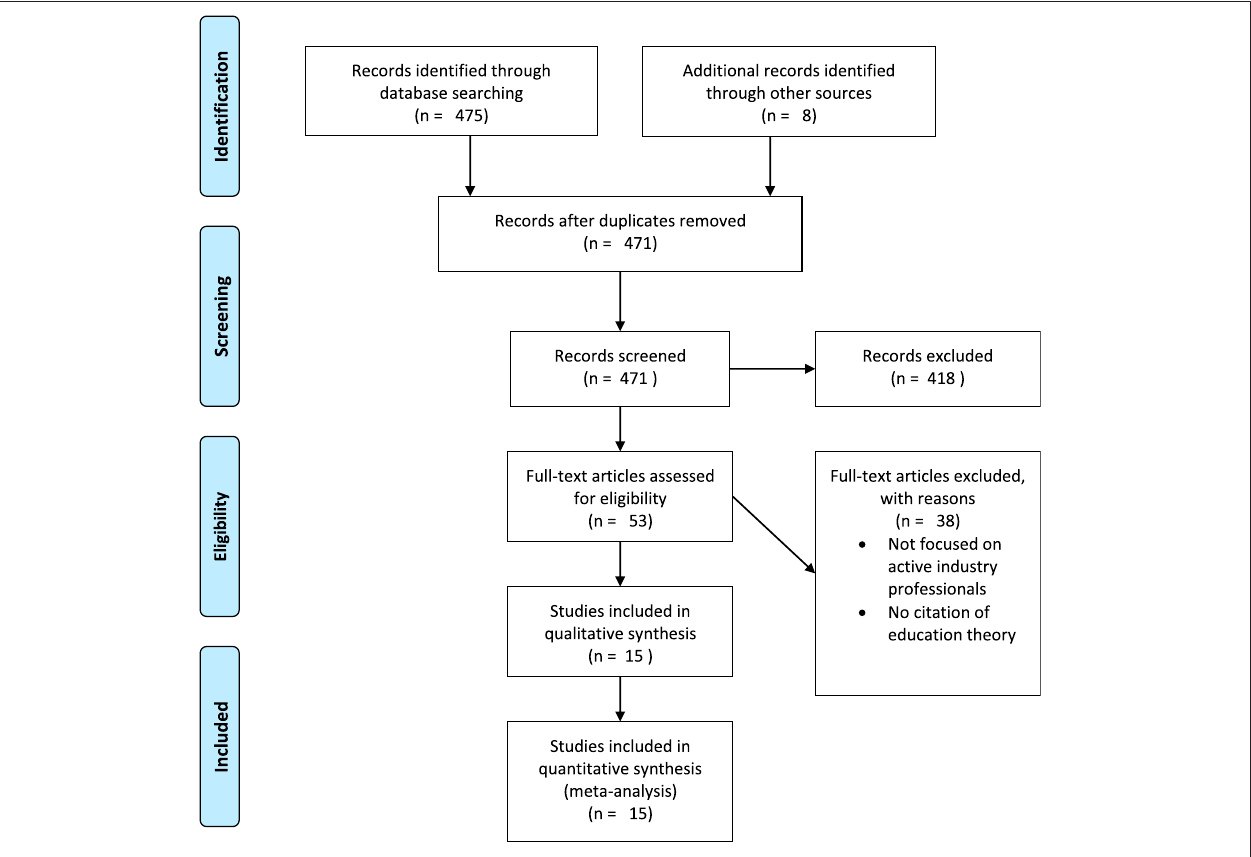
FIGURE 1 | PRISMA Flow Diagram of Studies Screened for Construction